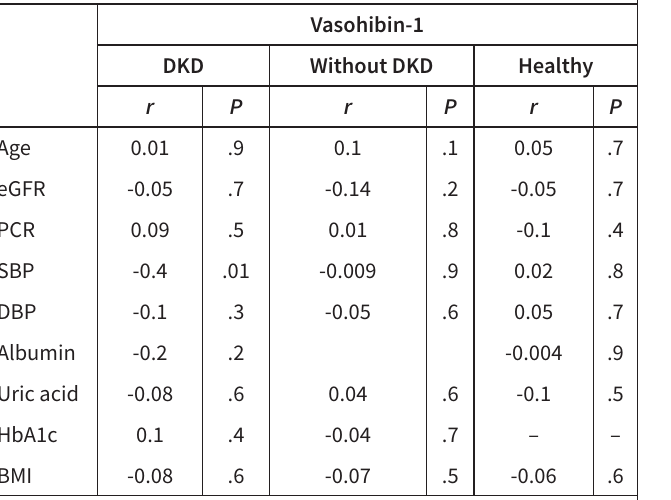
Table 3. Correlations of Vasohibin 1 and Various Parameters in All 3 Groups